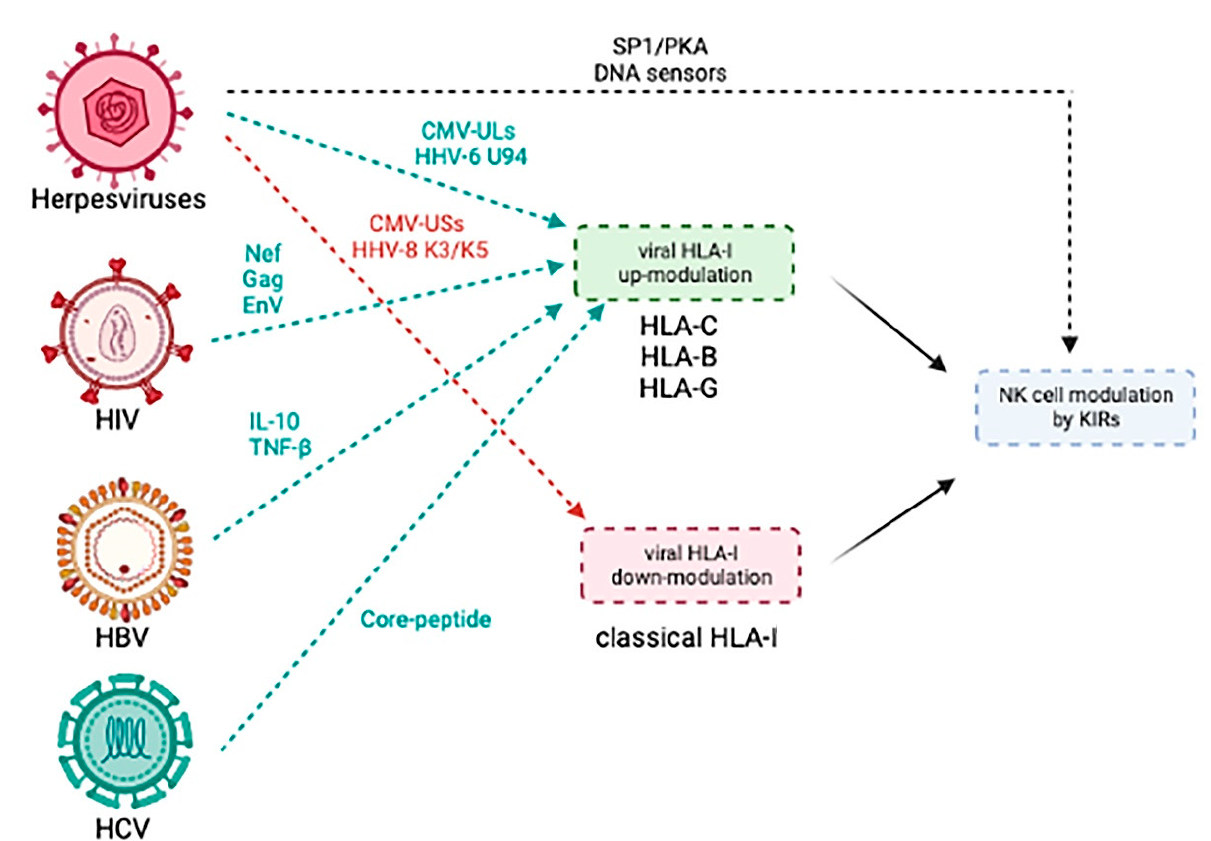
Figure 7. Schematic representation of the main viral strategy to modulate KIRs/HLA-I ligands described in the text. Viruses (e.g., Herpesviruses, HIV, HBV, and HCV) have evolved different mechanisms to modulate HLA-I molecules or induce/exploit specific KIRs expression, for example, by production of specific viral proteins to modify NK cell activation and evade host immune response.